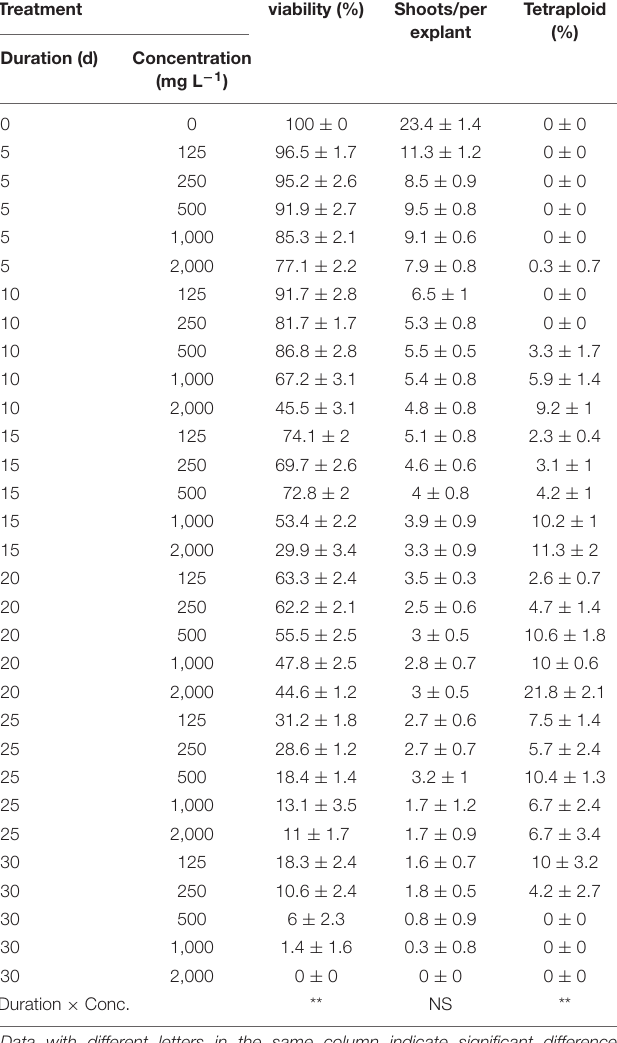
TABLE 2 | Interaction effect of colchicine concentration and duration on viability of explants, shoot regeneration, and tetraploid induction rate from garlic inflorescence on solid medium.